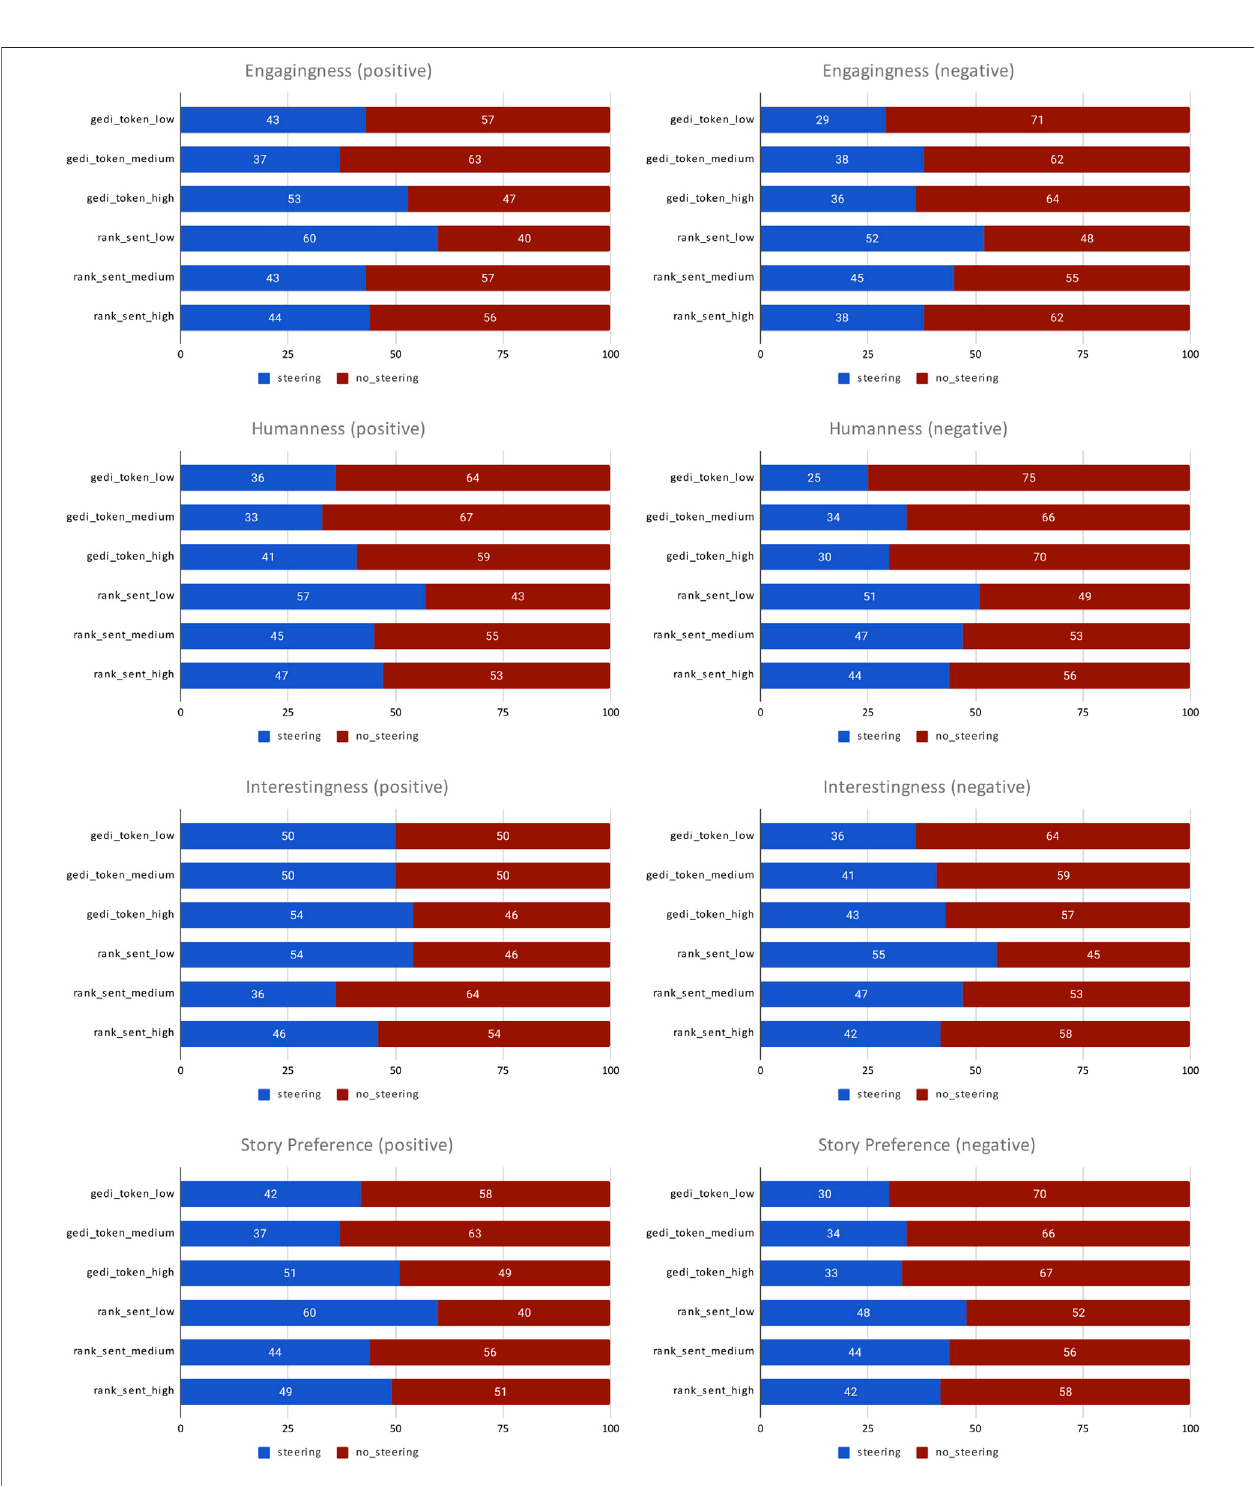
FIGURE10| Acute-EvalHumanevaluationofself-chatstorieswithsentimentsteering,comparingvarioussystemsagainsta tuned baselinewithoutsteering.The preferred system is indicated by a larger portion of the bar.